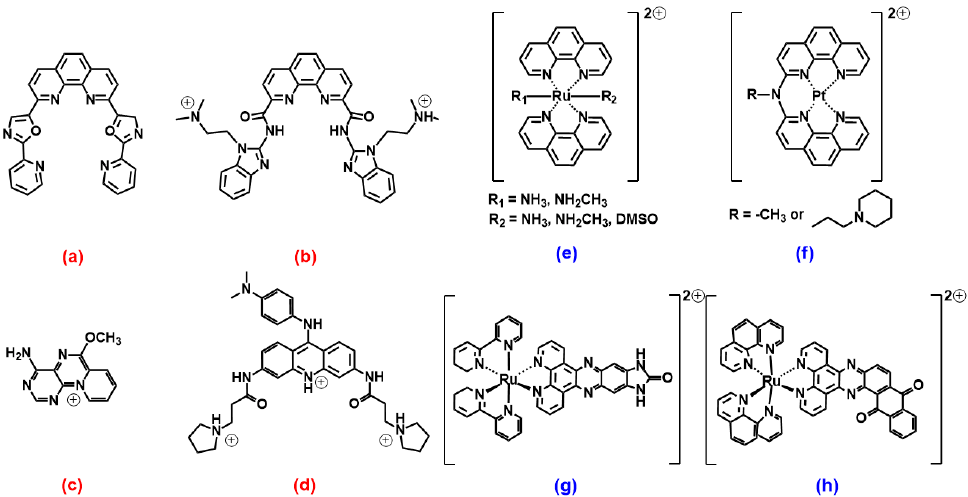
Figure 4. Molecular structures of the selective G4 binders of the phenanthroline family reviewed here: ( a ) [55], ( b ) [57], ( c ) [58], ( d ) [59], ( e ) [63], ( f ) [64], ( g ) [65] and ( h ) [66]. Red letters evidence parallel G4s’ high selectivity, blue letters correspond to molecules selective for antiparallel topology, and the systems with other/mixed behaviour have black lettering (absent here).